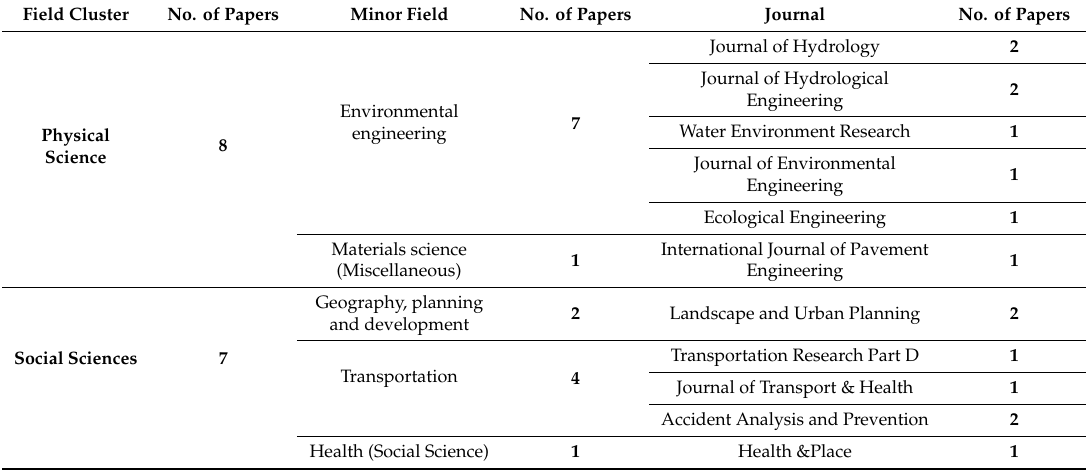
Table A1. Disciplines studying street infrastructure categorized according to